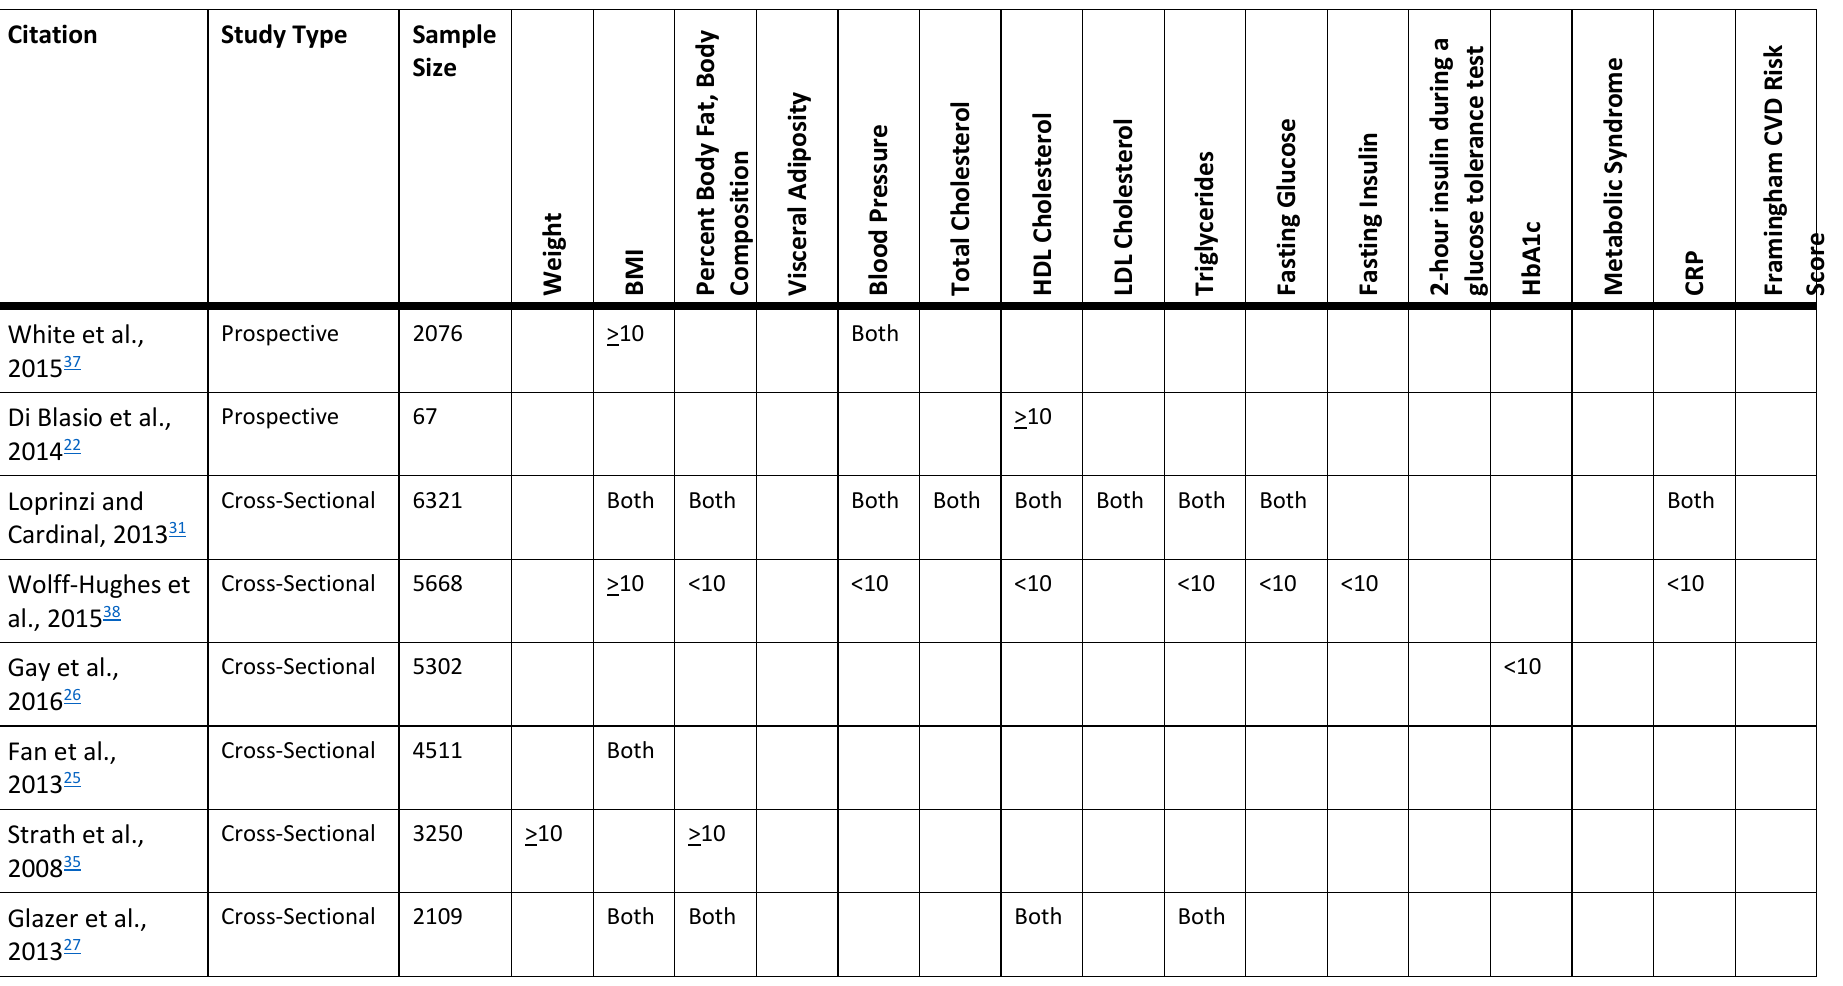
Table F1-1. Summary of the Association Between Physical Activity Bout Duration and Health Outcomes from Prospective and Cross-Sectional Studies that Included Bouts of Less than 10-minute Duration